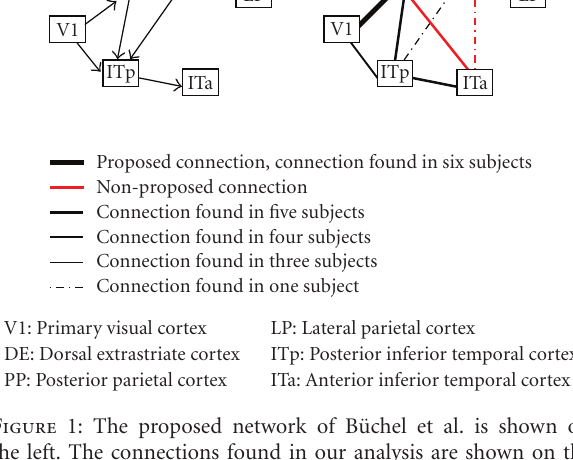
Figure 1: The proposed network of B¨uchel et al. is shown on the left. The connections found in our analysis are shown on the right. The legend indicates the meaning of the color scale and the thickness of the lines. This legend is valid for all the following figures.